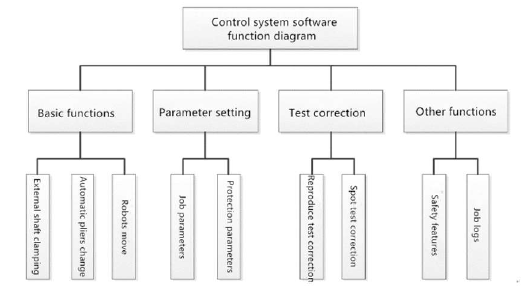
Figure 2. Control system function diagram of welding robot